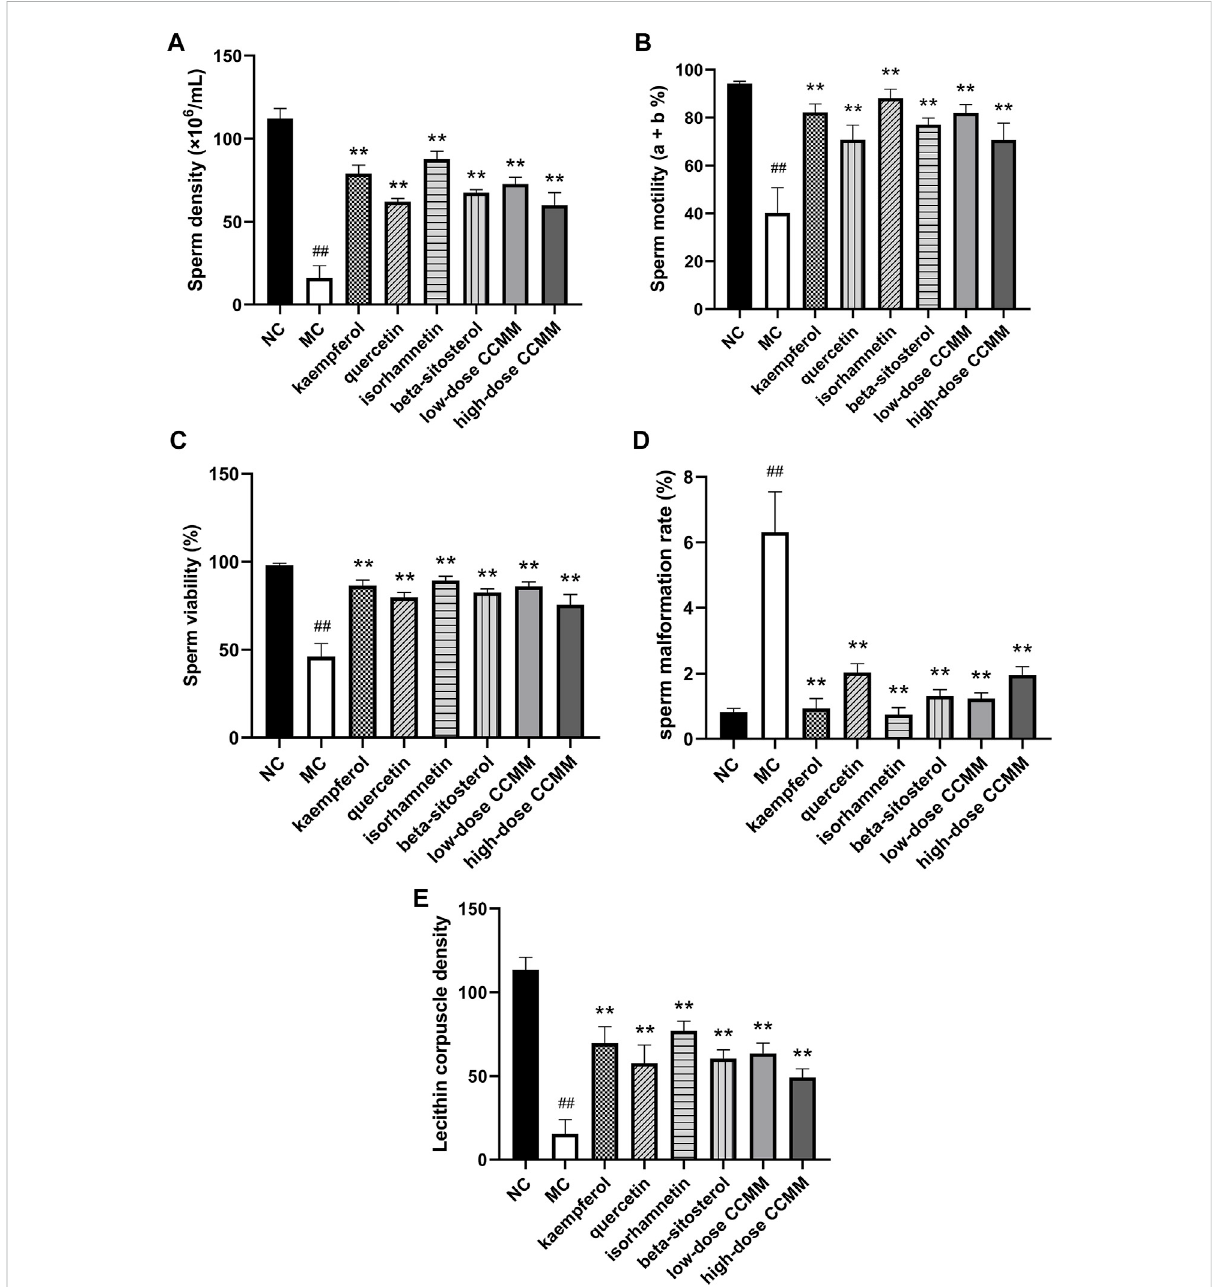
FIGURE 12 The sperm quality of each group. (A) The normal control group. (B) The model control group. (C) The kaempferol group. (D) The quercetin group. (E) The isorhamnetin group. (F) The beta-sitosterol group. (G) The low-dose CCMM group. (H) The high-dose CCMM group. Data: n = 8, mean ± SD, experiments performed in triplicate. ## p < 0.01 versus the NC group, ** p < 0.01 versus the MC